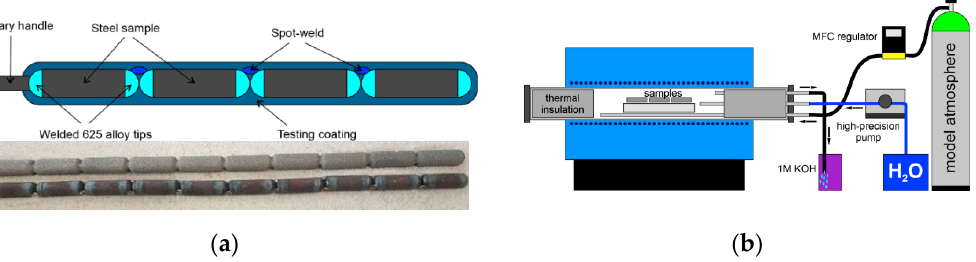
Figure 3. ( a ) Scheme/picture of testing a rod before cutting it into individual samples, with and without coating; ( b ) testing facility scheme. without coating; ( b ) testing facility